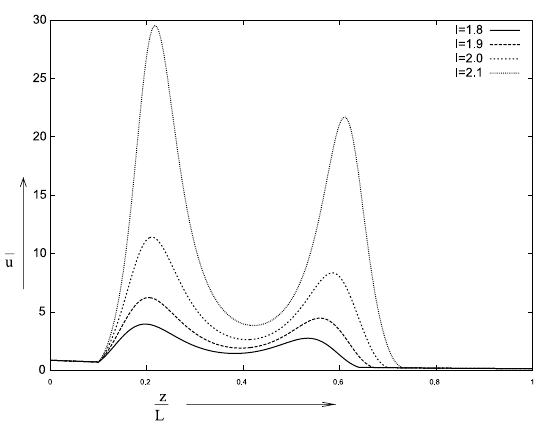
Fig. 3. Velocity distribution in the radial direction at different axial position z , when H = 0 . 2, M = 2 . 5, β = 2 . 5, α = 0 . 09 and k = 0 . 25.